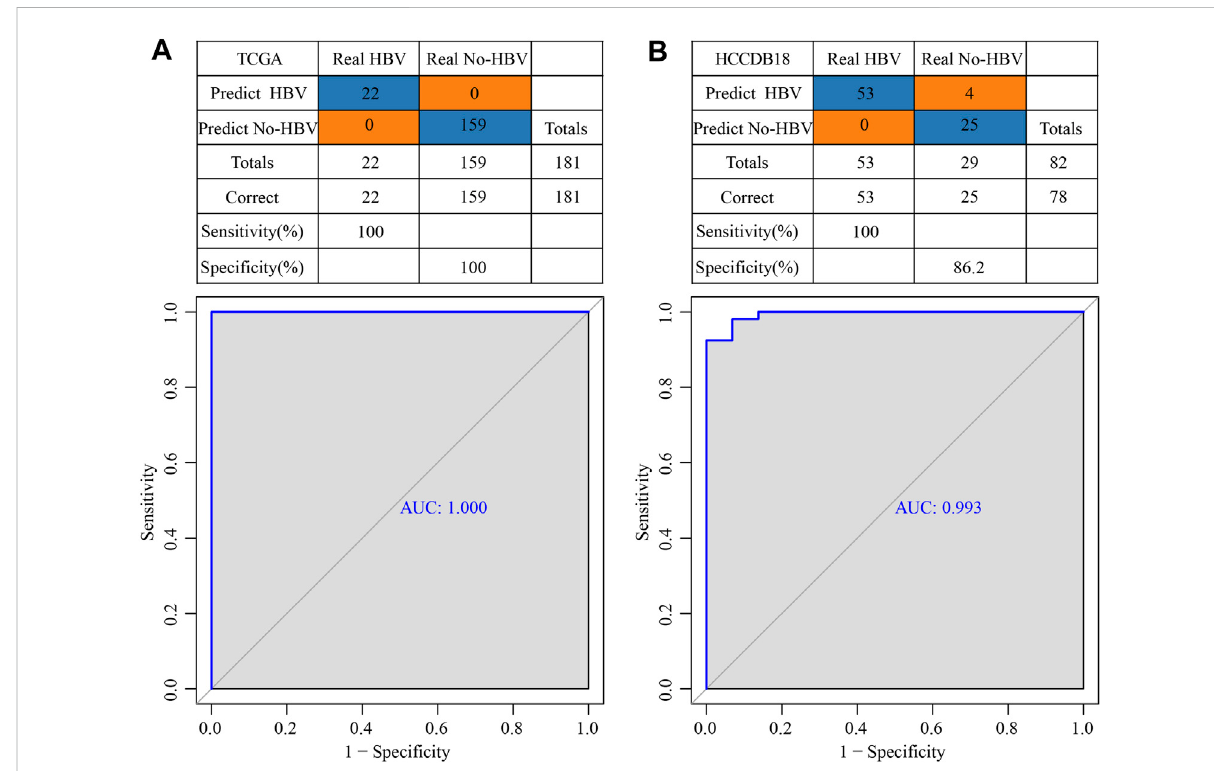
FIGURE 11 Construction of a diagnostic model of HBV gene in HCC. (A) The classi fi cation outcomes and ROC curves of samples in TCGA by diagnostic model; (B) The classi fi cation outcomes and ROC curves of samples in HCCDB18 samples by diagnostic